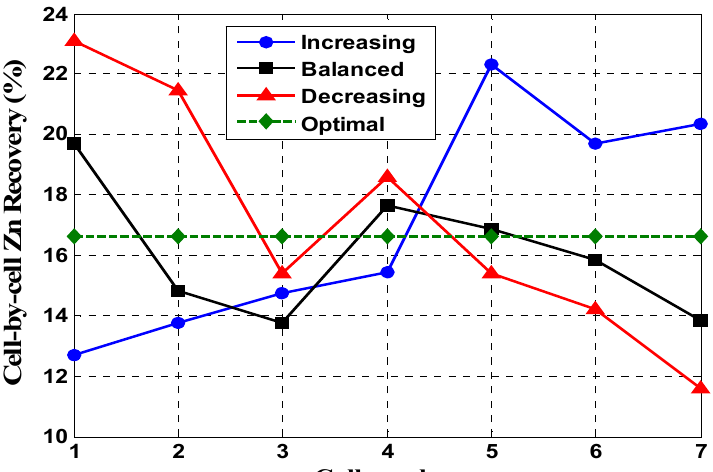
Figure 10. Cell-by-cell Zn recovery profiles resulting from implementing an increasing, balance and decreasing air rate profiling, and optimal theoretical flat cell-by-cell recovery for a Zn bank recovery of